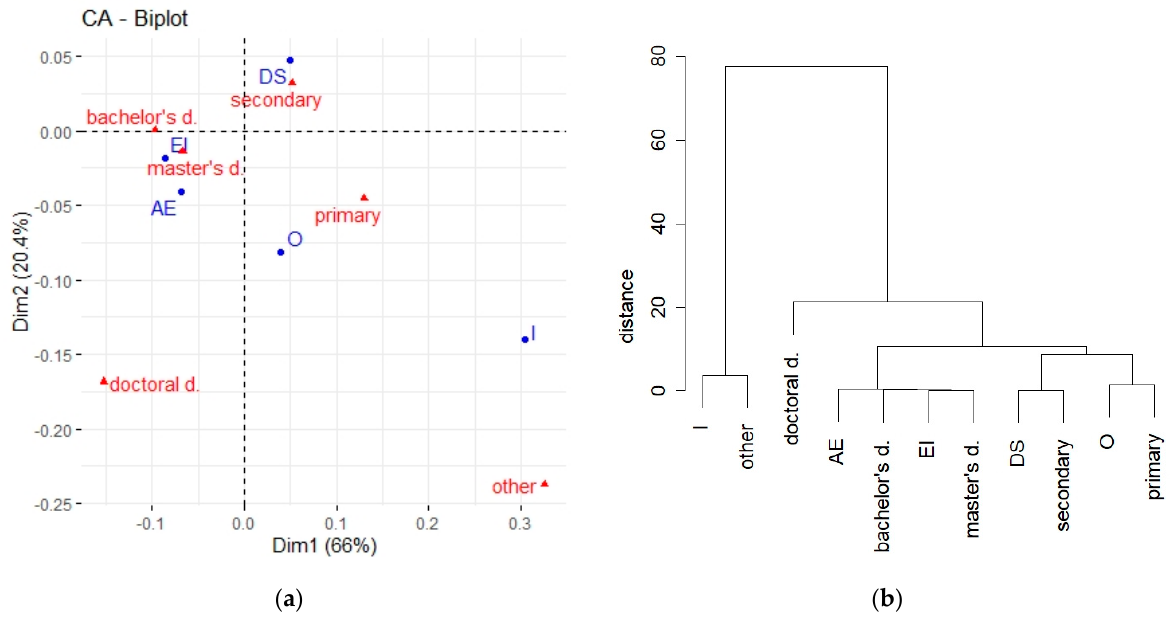
Figure 7. Correspondence map ( a ) and an auxiliary dendrogram ( b ) showing the dependence of each behavioural type of energy consumer on their education.